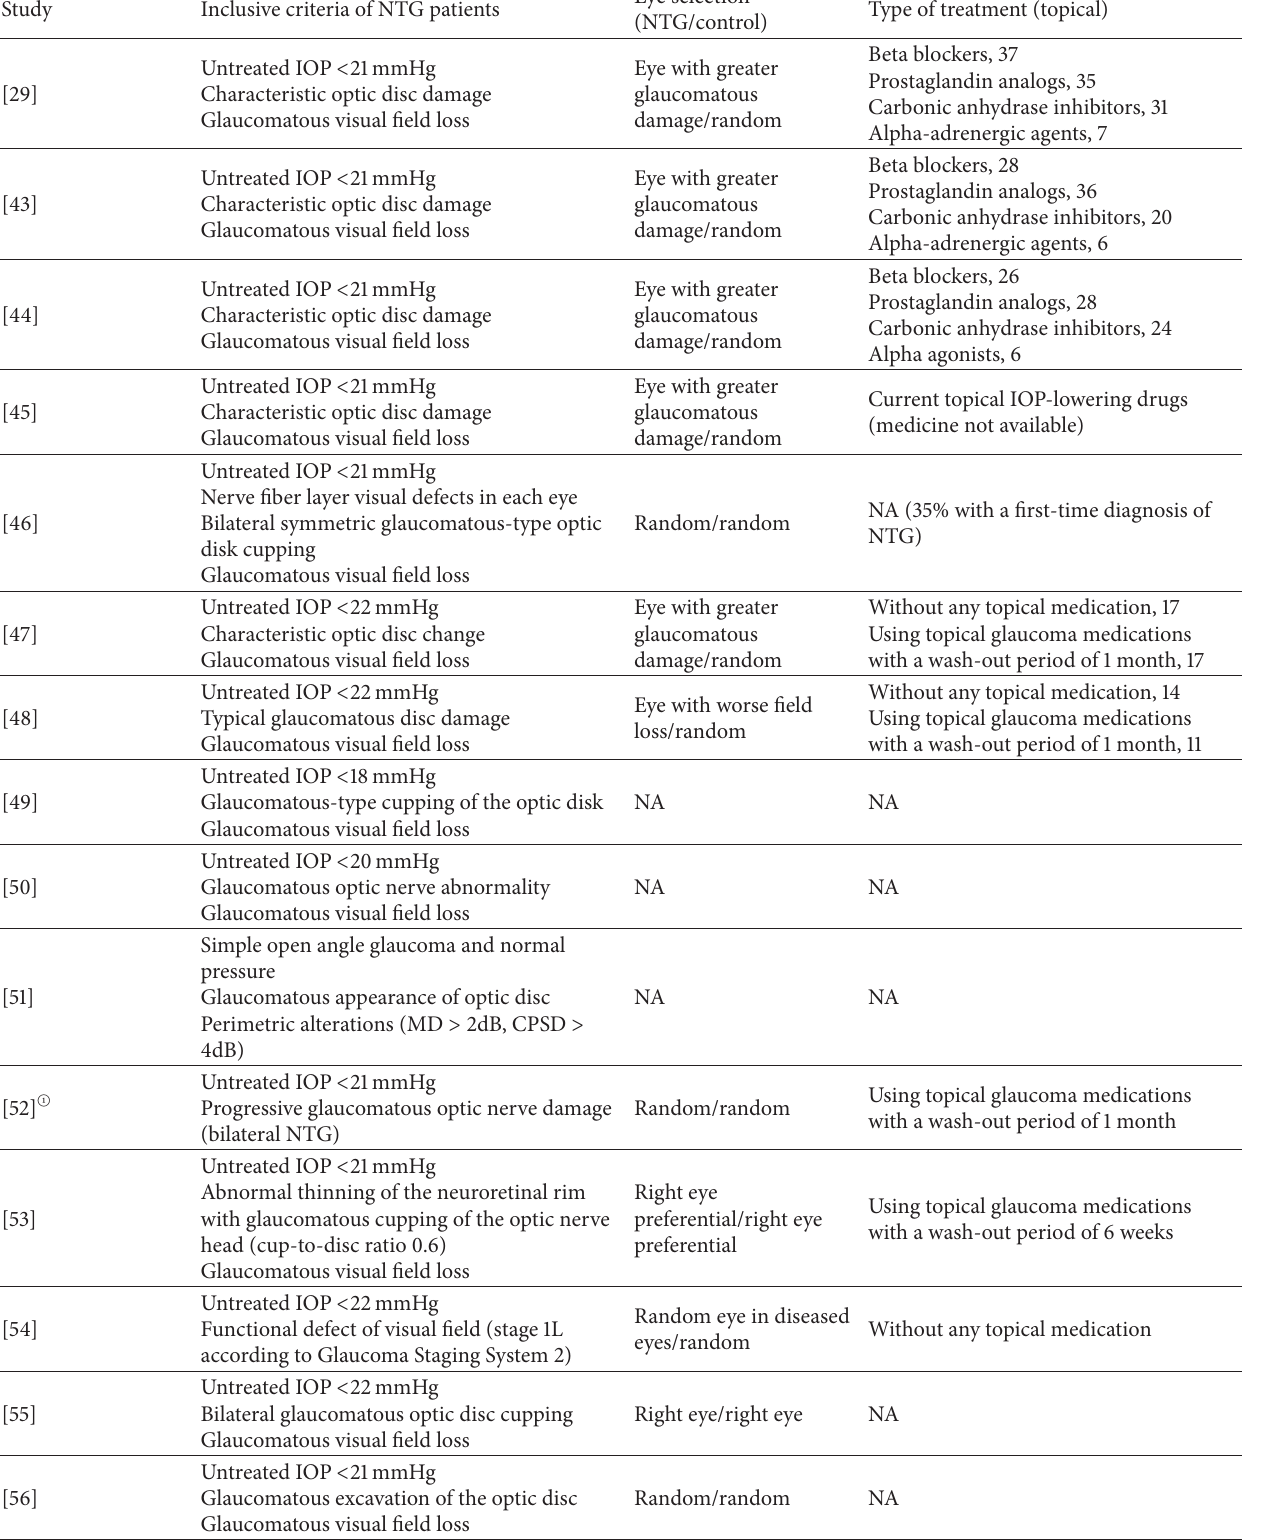
Table 4: Quality-related data of the included